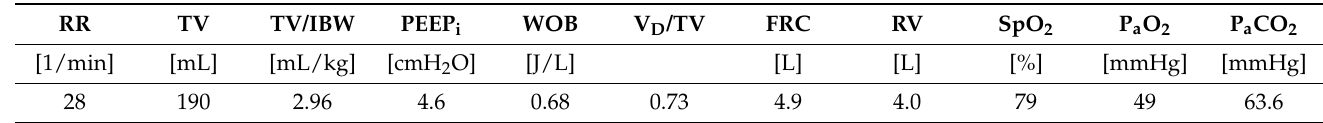
Table A1. Breathing parameters and physiological indices during simulation of severe COPD.